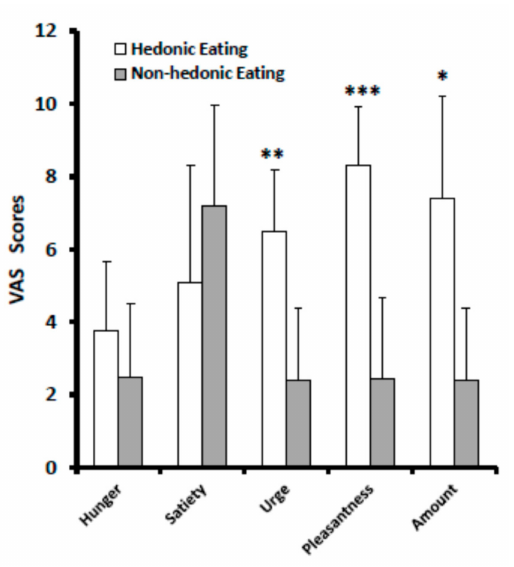
Figure 1. Visual analogue scale (VAS) scores in obese patients with binge-eating disorder in hedonic and non-hedonic eating. Data are expressed as mean ± SD. * p = 0.01, ** p = 0.007, *** p = 0.001 as compared to non-hedonic eating.